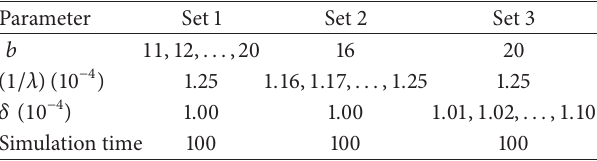
Table 3: Simulation parameters.